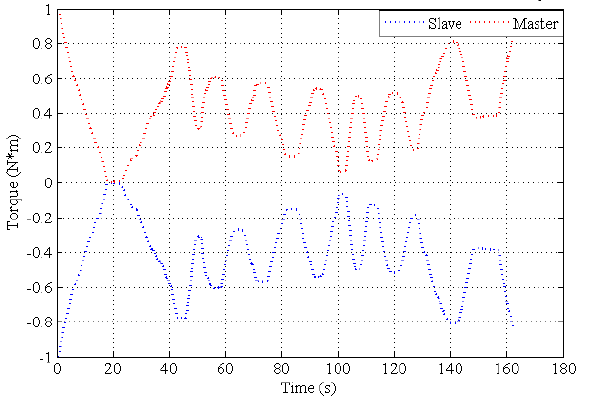
Figure 14. Normalized estimated perturbation of end effectors for master and slave.